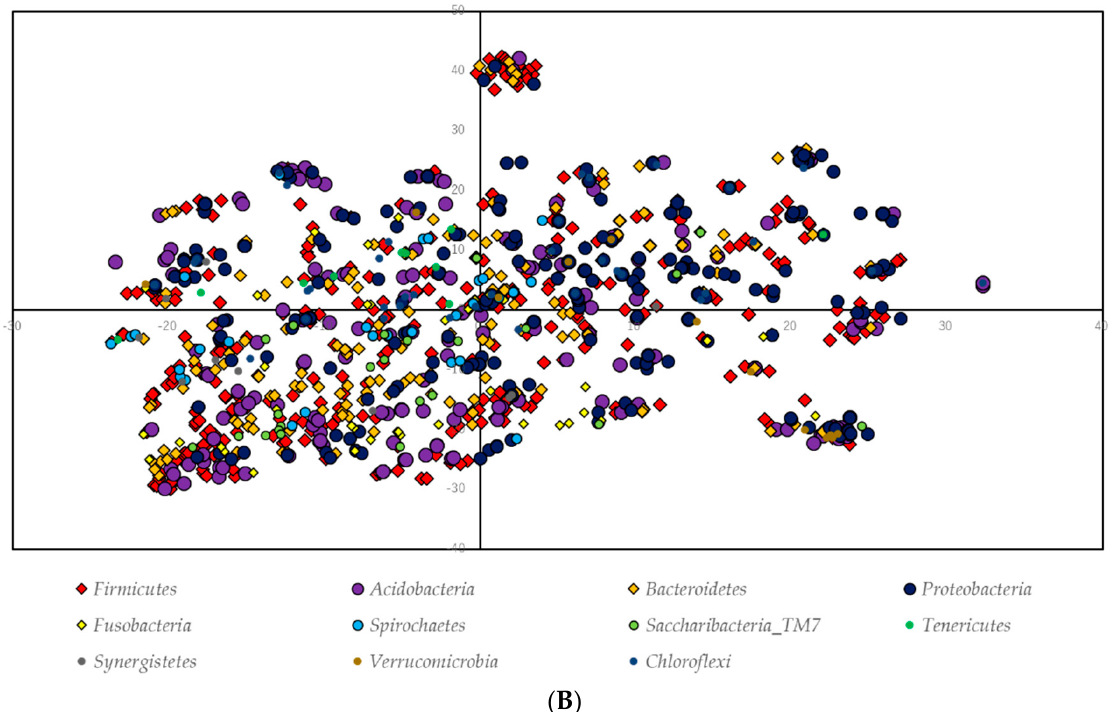
Figure 4. Ordination analysis as a function of t-distributed stochastic neighbor embedding (t-SNE) plot categorized by ( A ) prevalence and ( B ) genus.